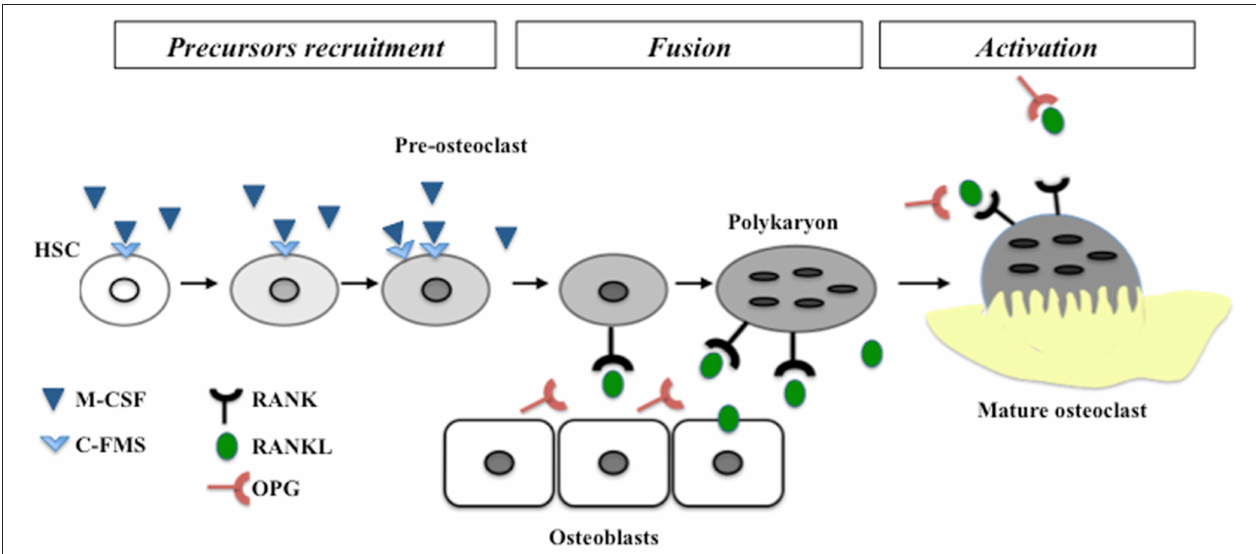
FIGURE 1 | Schematic representation of different steps of osteoclastogenesis. The two mains factors controlling the differentiation called M-CSF and RANKL are represented with their receptors. M-CSF is necessary to recruitment and expression of RANK at the surface of pre-osteoclasts. RANKL enable the fusion of pre-osteoclasts in polykaryon and the final differentiation in mature osteoclasts. HSC, hematopoietic stem